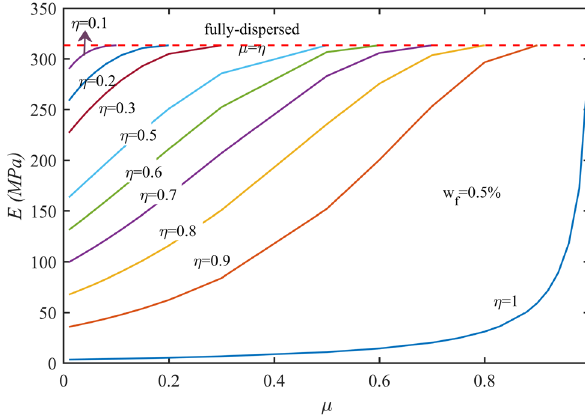
Figure 7: Young ’ s modulus of PDMS/MWCNT nanocomposite obtained from HT approach versus MWCNT aspect ratio for di ff erent nano fi ller weight fractions.